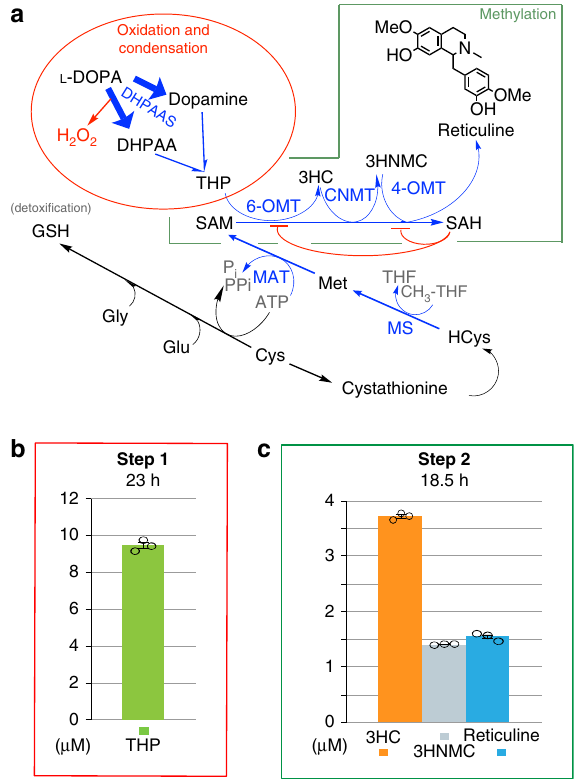
Fig. 9 Metabolomics directed optimization of ( R , S )-THP and reticuline production. a Monitored metabolites including homocysteine (HCys) and glutathione (GSH) are listed in black text, whereas unmeasured metabolites are listed in graey. Lower relative levels of 3-hydroxycoclaurine (3HC) and reticuline suggested that a bottleneck was strongest at 6-OMT and 4-OMT steps, which are inhibited by S -adenosylhomocysteine (SAH) as illustrated by the red fl at-headed curves 33 . Lower utilization of S -adenosylmethionine (SAM) and higher accumulation of SAH accompanied stronger THP to reticuline bottlenecks. Desired pathways mediated by DHPAAS, 6-OMT, CNMT, 4-OMT, methionine synthase (MS), and methionine adenosyltransferase (MAT) are shown in blue. b , c Titers of THP, 3HC, 3- hydroxy- N -methylcoclaurine (3HNMC), and reticuline from 1 mM L -DOPA using a two-step cell process as described in the methods section. THP was quanti fi ed 23 h after L -DOPA adddition and three downstream BIAs were quanti fi ed 18.5 h after addition of the second bioproducer. Here, error bars de fi ne the standard error of the mean ( n = 3 independent measurements). Source data of Fig. 9 panels b and c are provided in a Source Data fi